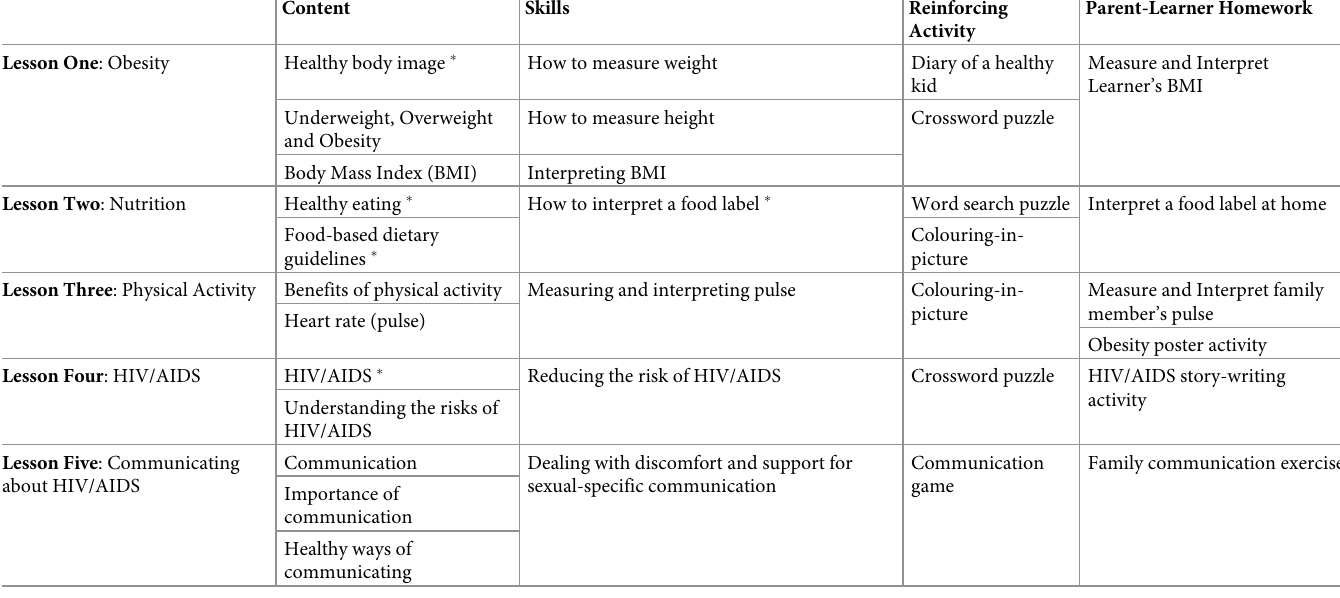
Table 1. Overview of lesson